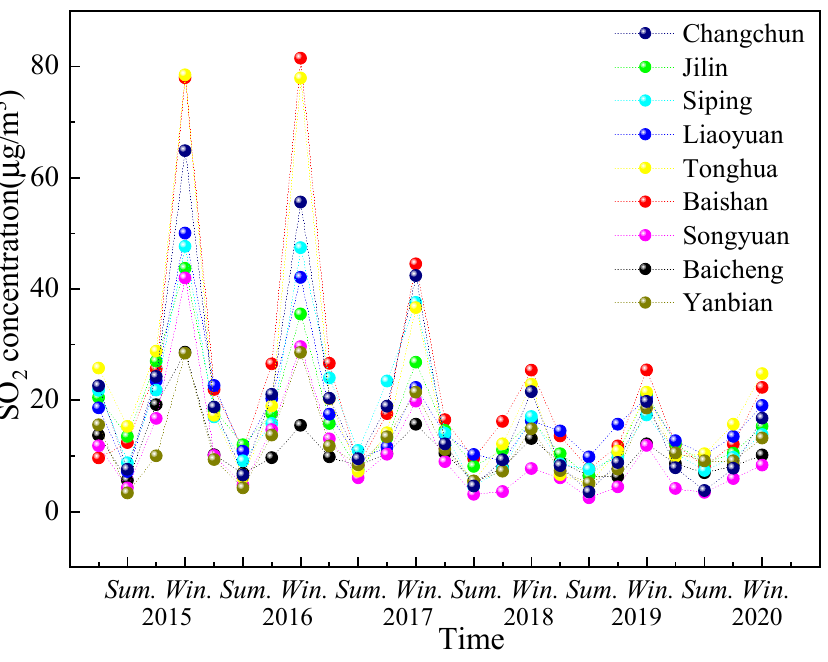
Figure 4. Variation of SO 2 concentration in different seasons from 2015–2020. Table 8 shows the relationship between the SO 2 concentration and the vegetation parameters across the different seasons from 2015–2020. The results show that there is a significant negative correlation between the SO 2 concentration and FPAR, LAI, and NDVI values in each city. This means that the values of the vegetation parameters decreased with an increase in the SO 2 concentration. The pattern of SO 2 concentration and the vegetation parameters across the different cities and seasons from 2015–2020 remained just about constant. To highlight the comparability among the different indicators, normalization was first performed. Figure 5 shows the trends in the SO 2 concentration and vegetation parameters during the different seasons in Changchun and Baishan City from 2015–2020. The results show that there was an opposite trend between SO 2 concentration and the vegetation parameters with changes in seasons.